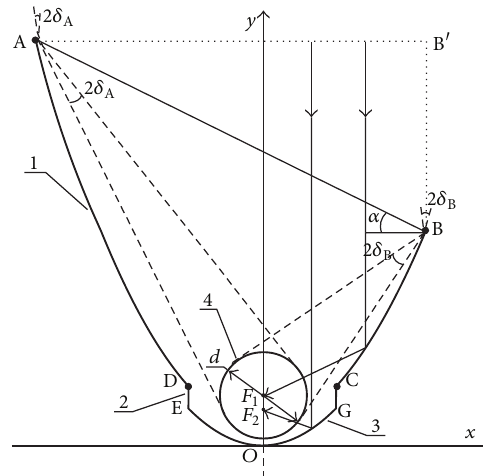
Figure 1: A cross-sectional view of the compound curved surface